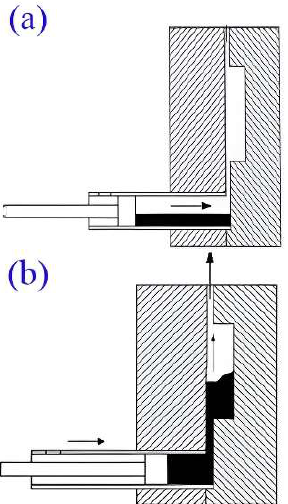
Figure 3. Discharge principle of existing fan bearing grease ( a ); discharge principle of fan bearing grease under vacuum condition ( b ).